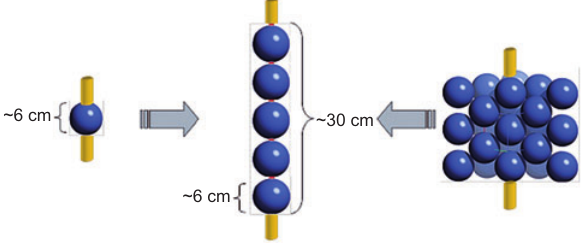
Figure 1 Monomode resonator concept for a microwave fl ow reactor merging the benefi ts of existing mono- and multimode technologies. Left: monomode fl ow concept; right: multimode fl ow concept; cen- ter: cylindrical waveguide in the fundamental mode TM ized cylindrical reaction tube is shown in